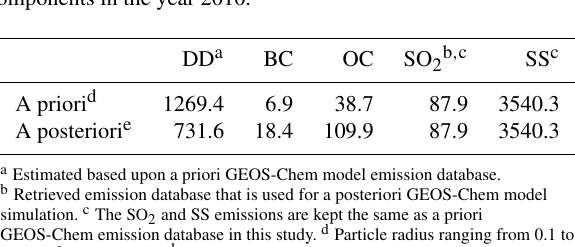
Table 1. Total source strengths (unit: Tgyr − 1 ) of five major aerosol components in the year 2010.